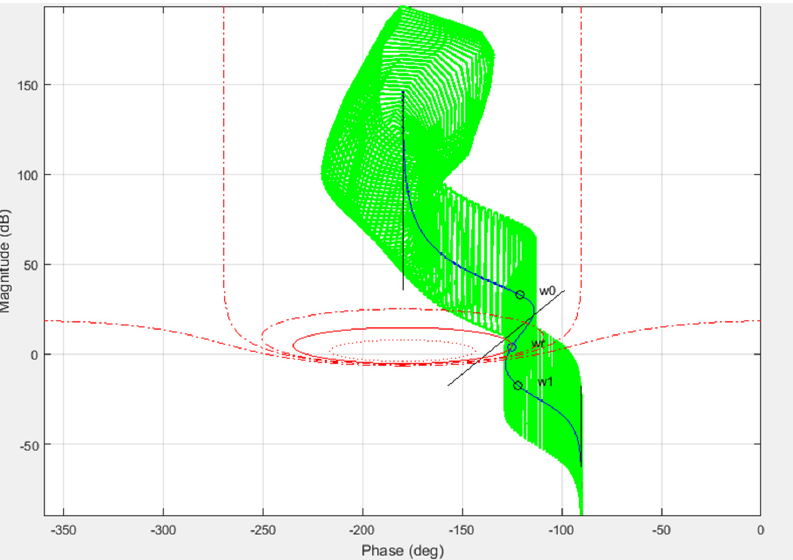
Figure 7. Nichols chart of the open loop for the uncertainty domains ( green ) associated with the nominal plant ( blue ) and Nichols abacus ( red ).